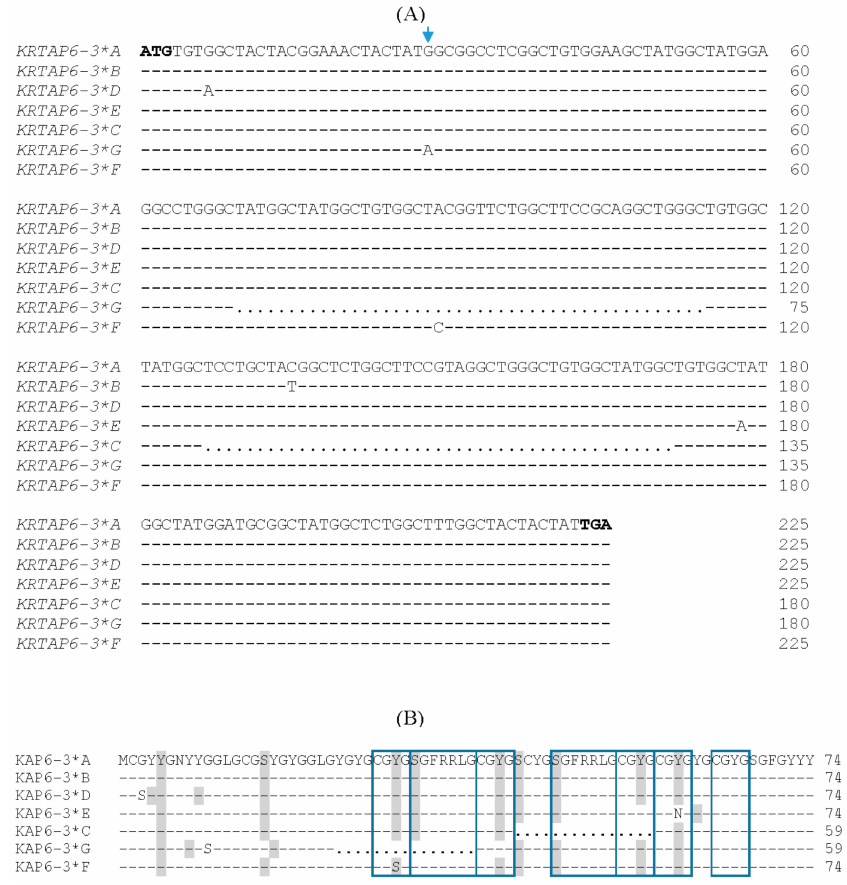
Figure 2. Sequence comparisons of the newly identified and previously described variants of ovine KRTAP6-3 . ( A ) Alignment of the nucleotide sequences revealed five single nucleotide polymorphisms (SNPs) and two 45-bp deletions in the gene; ( B ) These nucleotide sequence variations would lead to four amino acid changes and two deletions of 15 amino acids in the central region of the putative protein, which contains repeats of the sequences CGYG and SGFRRLG. Nucleotides or amino acid residues identical to the top sequence are indicated by dashes, and dots represent deletions. The arrow indicates the new SNP identified in this study, and the boxes indicate repeats of amino acid motifs. Residues that could be phosphorylated are